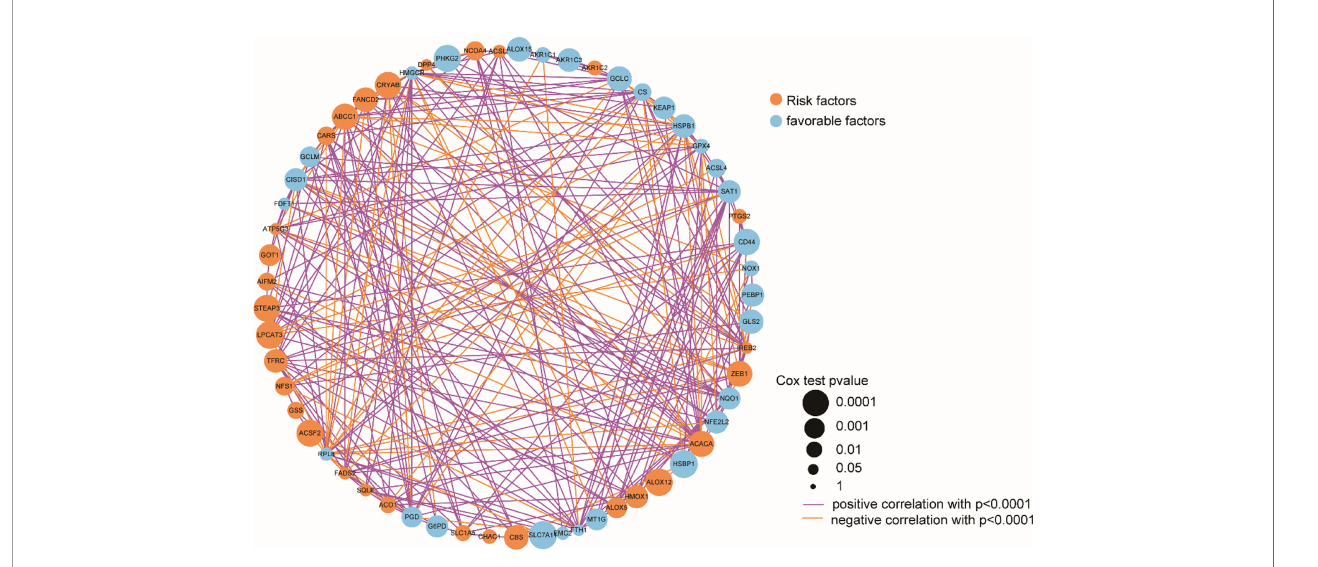
FIGURE 4 | Correlation of 60 ferroptosis-related gene